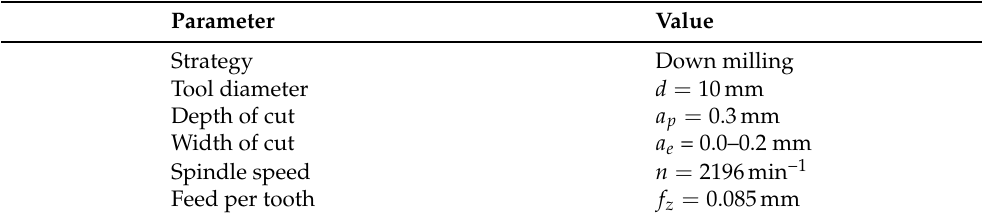
Table 3. Parameter values of the milling process.